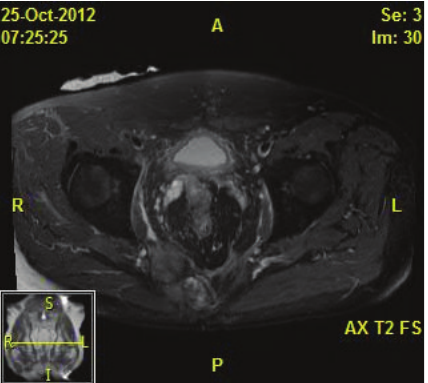
Figure 1: Biopsy-proven recurrent rectal adenocarcinoma invading the sacrum.